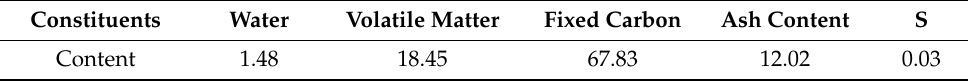
Table 2. Industrial analysis of coal